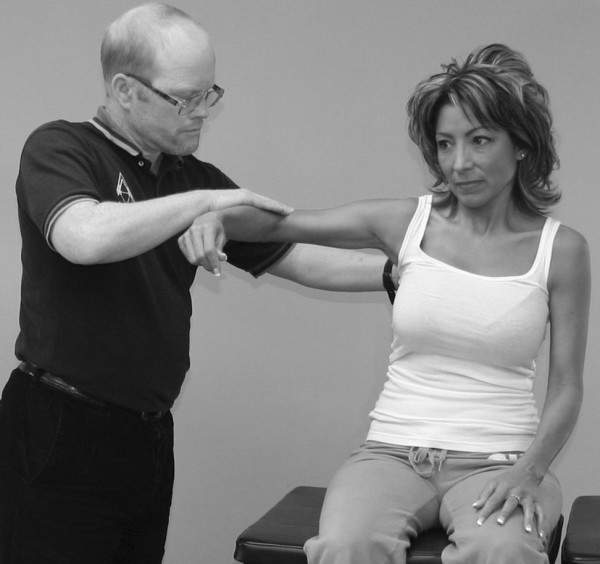
Middle deltoid MMT.